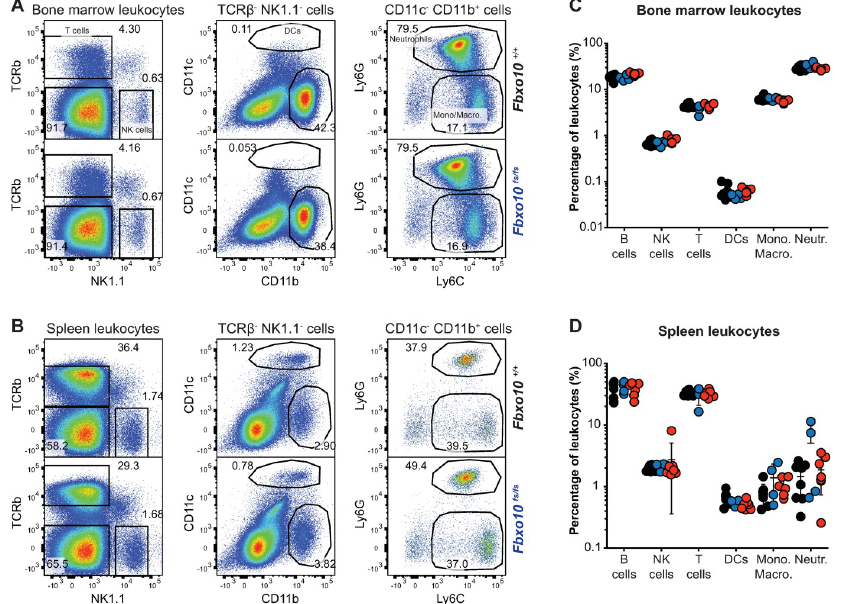
Fig 6. Fbxo10 frameshift or missense mutation do not cause discernable differences in myeloid and lymphoid leukocytes within the spleen or bone marrow. (A) Representative flow cytometry gating strategy to delineate leukocyte populations in the bone marrow. Numbers denote cells in gate as percentage of parent population. (B) Representative flow cytometric gating strategy to delineate leukocyte populations in the spleen. (C) Leukocyte subsets in the bone marrow of Fbxo10 +/+ , Fbxo10 fs/fs , Fbxo10 E54K/E54K mice. (D) Leukocyte subsets in the spleen of Fbxo10 +/+ , Fbxo10 fs/fs , Fbxo10 E54K/E54K mice. C, D: each dot represents an individual biological replicate. Results representative of n = 2 experiments on mice 40–50 weeks old, and similar results observed in n = 2 experiments on mice 10–20 weeks old. Fbxo10 +/+ in black, Fbxo10 fs/fs in blue, Fbxo10 E54K/E54K in red. Statistical analysis: t-test corrected for multiple comparisons using the Holm-Sidak method yielded no evidence for significant differences between mutants and wildtype controls with p < 0.05.